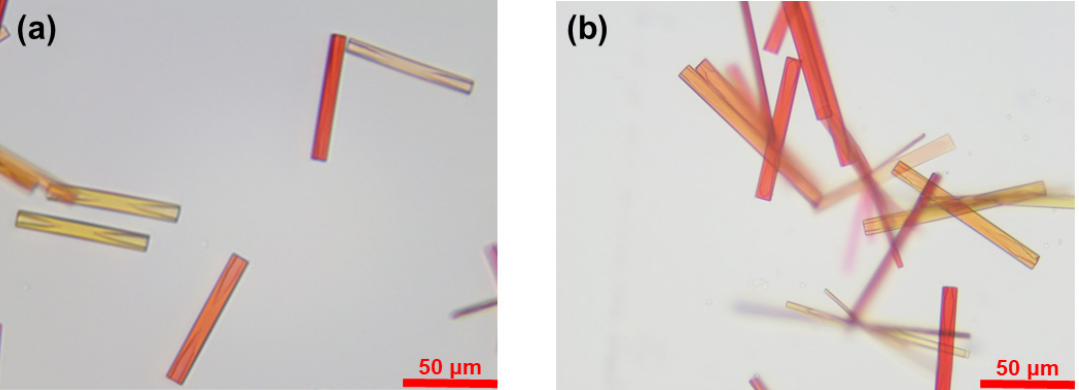
Figure 7. Optical microscopy images of APE-TCNB hollow cocrystals before ( a ) and after ( b ) 30 min intense sonication.